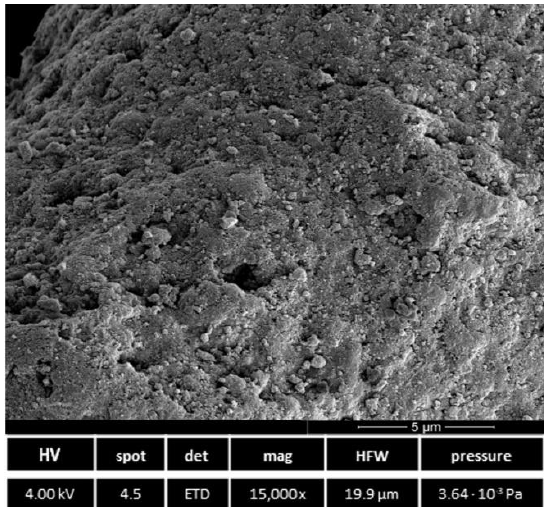
Figure 5. Micrograph obtained through SEM of the catalyst support (SiAl) after thermal treatment (600 °C for 25 h).